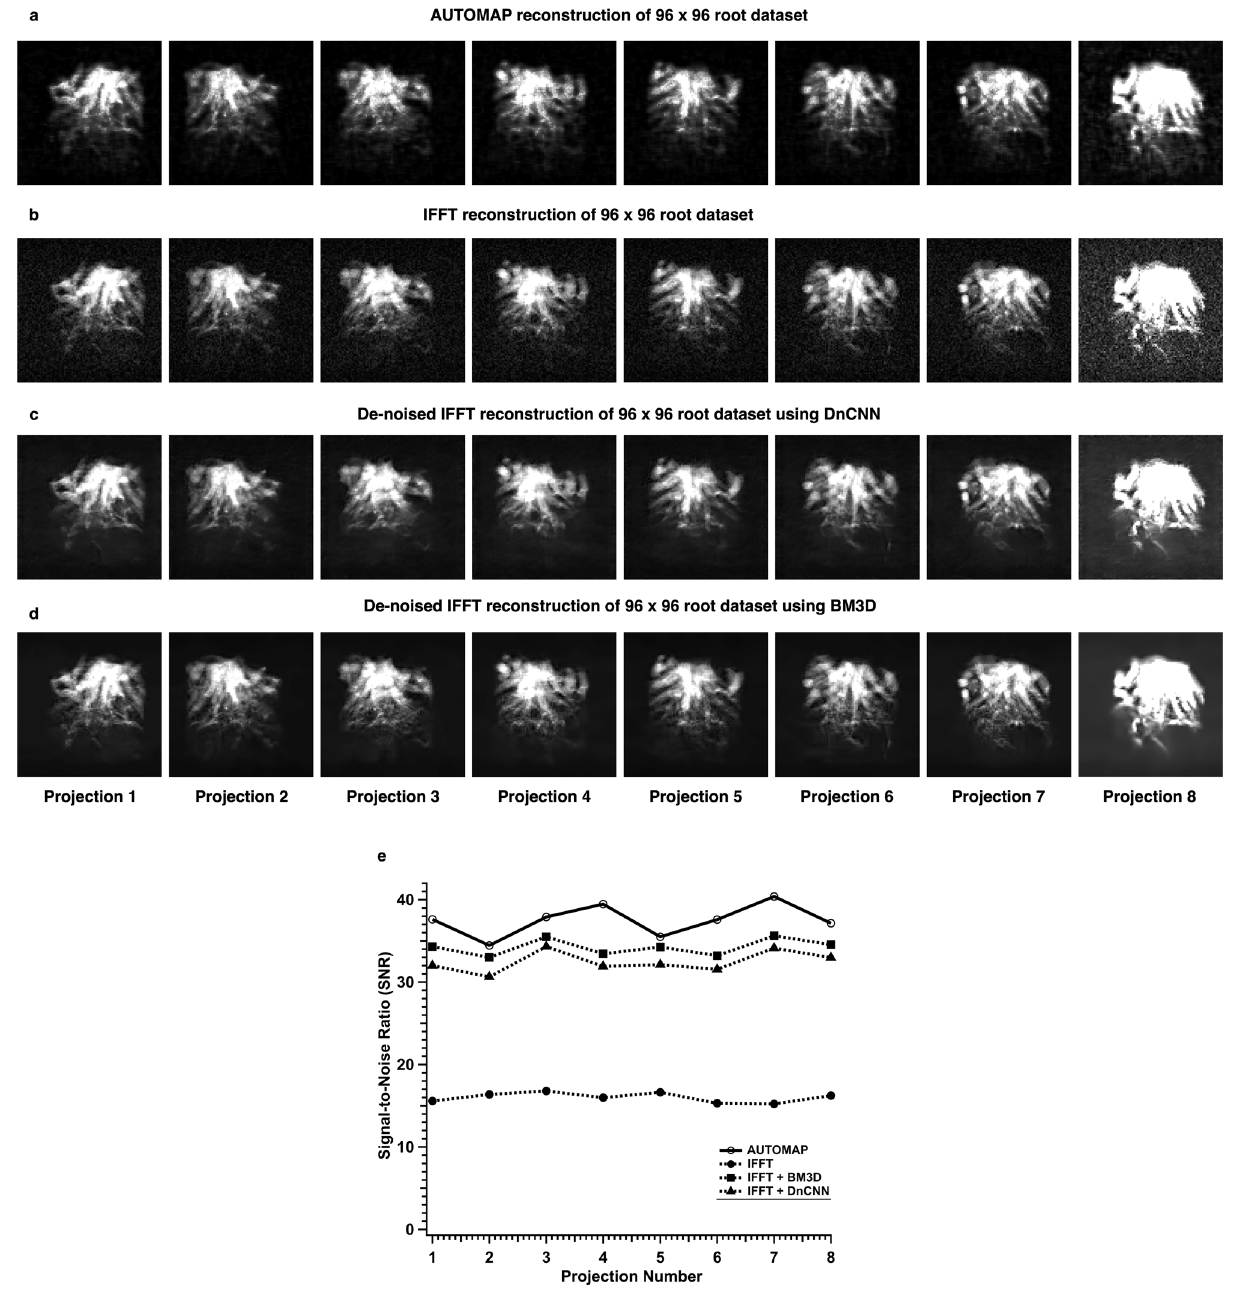
Figure 8. AUTOMAP reconstruction using the RootBox synthetic roots database versus IFFT reconstruction of a 96 × 96 root dataset. All eight 2D projections reconstructed with AUTOMAP are shown in ( a ), and with IFFT in ( b ). Each of the magnitude image was processed with either DnCNN as shown in the third panel ( c ) or with BM3D in the fourth panel ( d ) The window level for projections 1–7 were set to the same value except for projection 8, where the threshold was lowered on both panels to reveal the noise floor differences. To generate figure ( e ), the SNR was evaluated for AUTOMAP reconstruction using the RootBox training and compared to IFFT reconstruction with and without the denoising pipelines, and the SNR of each of the 8 projections reconstructed with AUTOMAP (open circle), IFFT without the denoising algorithm (filled circle), IFFT with BM3D (filled square), and IFFT with DnCNN (filled triangle) is